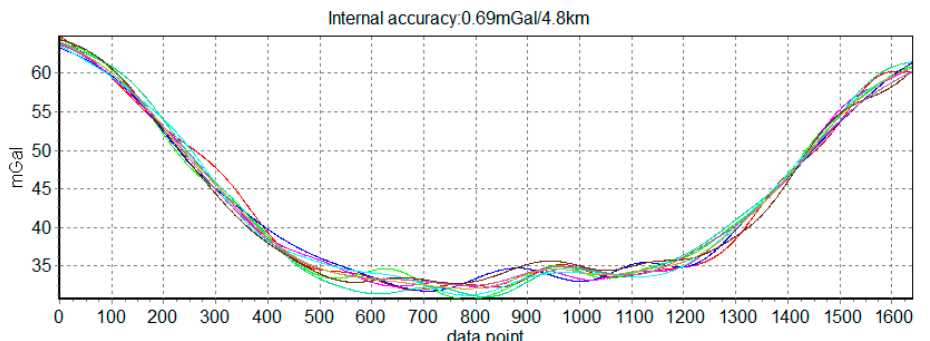
Figure 11. Paths of two repeat line flight.